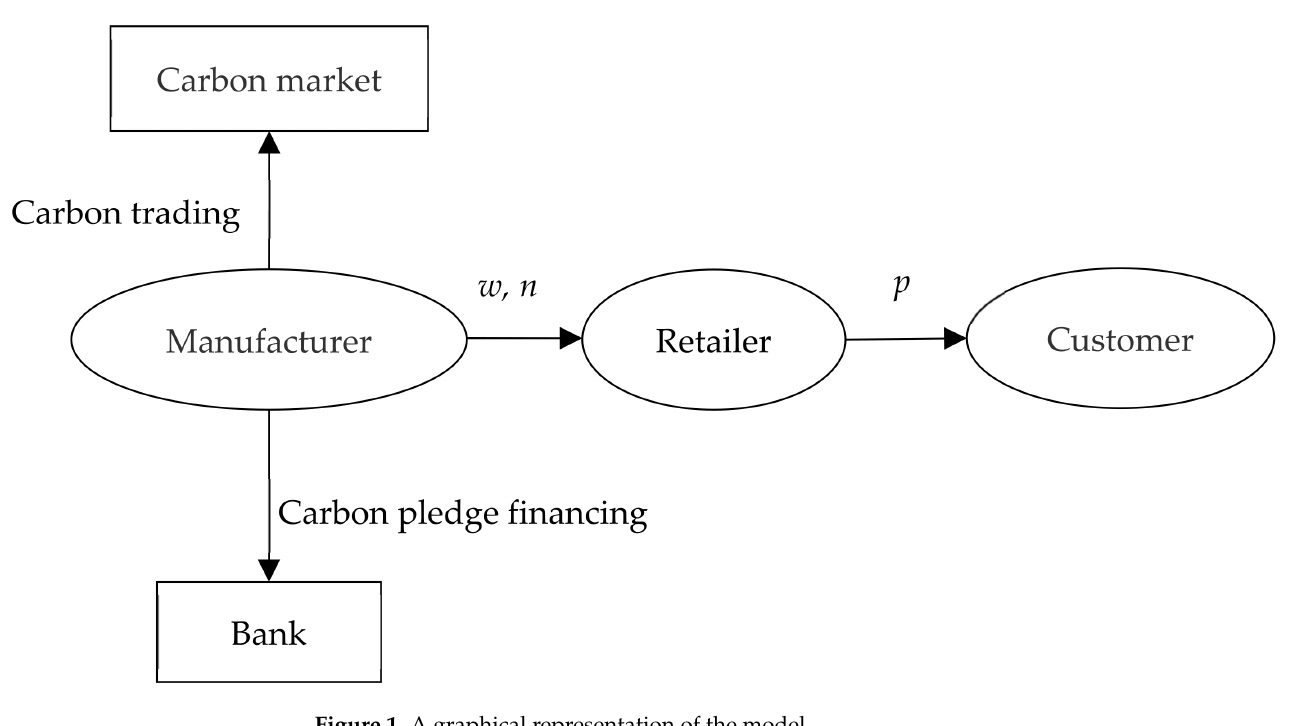
Figure 1. A graphical representation of the